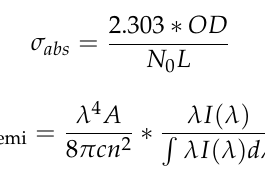
Figure 7. ( a ) Absorption and ( b ) Emission spectra of Yb 3+ ions in the YAS and YABS glass ( λ ex = 896 nm).